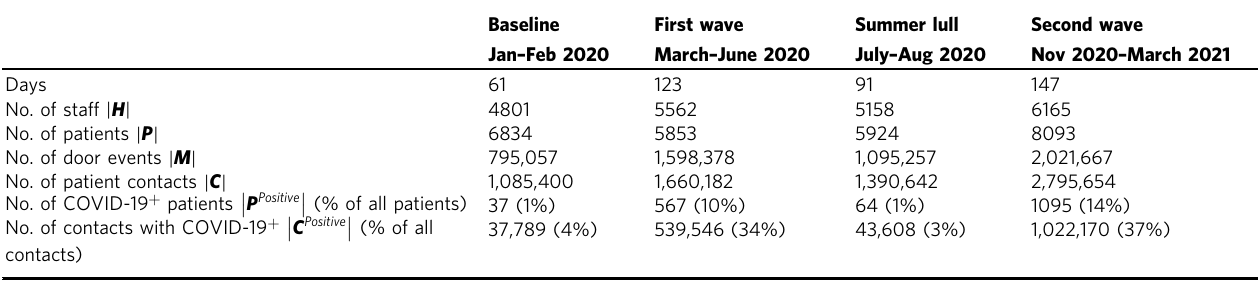
Table 2 Summary for metrics on healthcare worker behaviour derived from routinely collected data at the Tower building of University College London Hospital during the fi rst year of the COVID-19 pandemic.